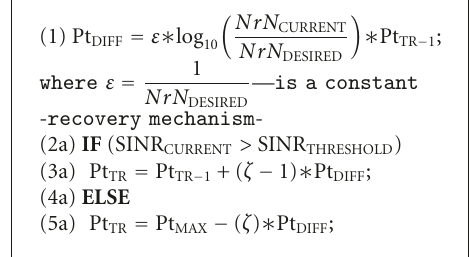
Algorithm 2: Enhanced power